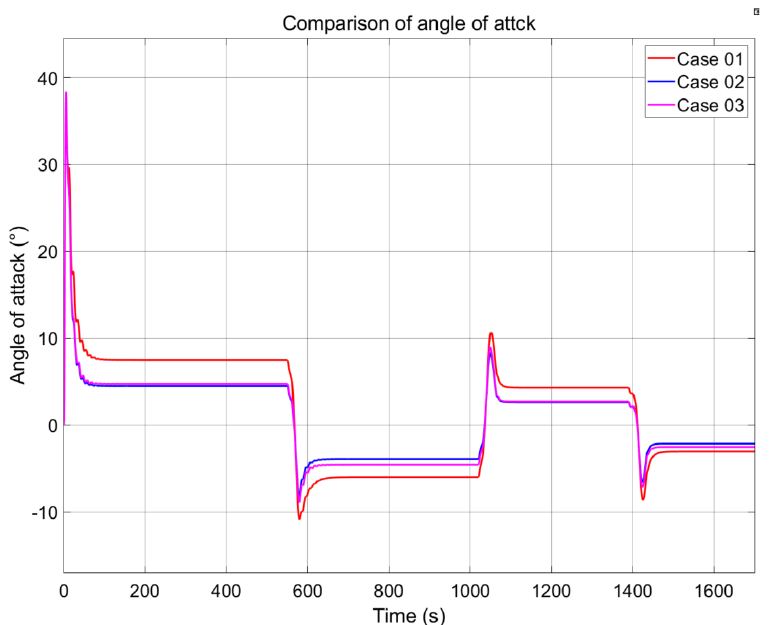
Figure 16. Comparison of AOA.